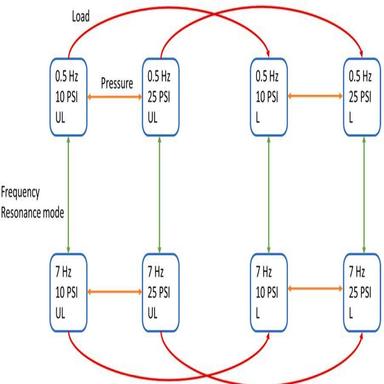
Design of experiments – parameter effect.